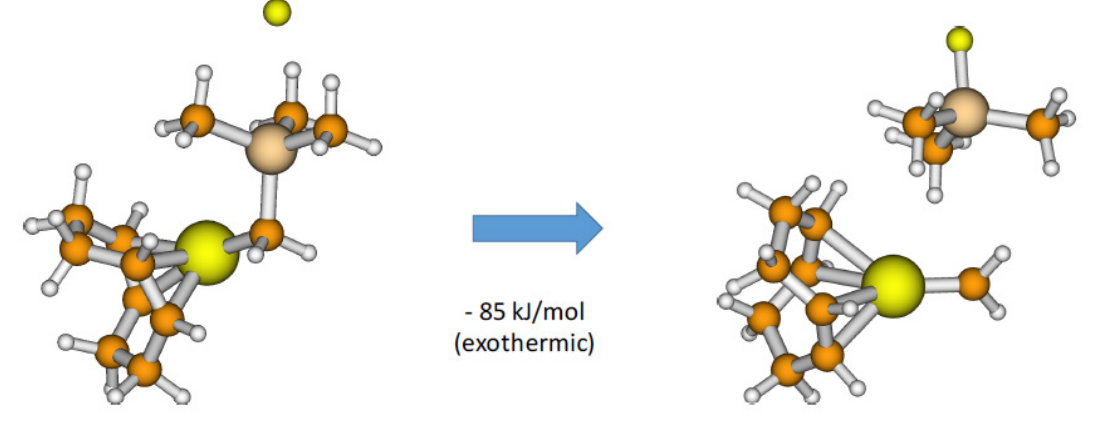
Figure 3: DFT optimised structures of the reaction of [Pt(cod)(neoSi)] + + F – (in acetone solution).